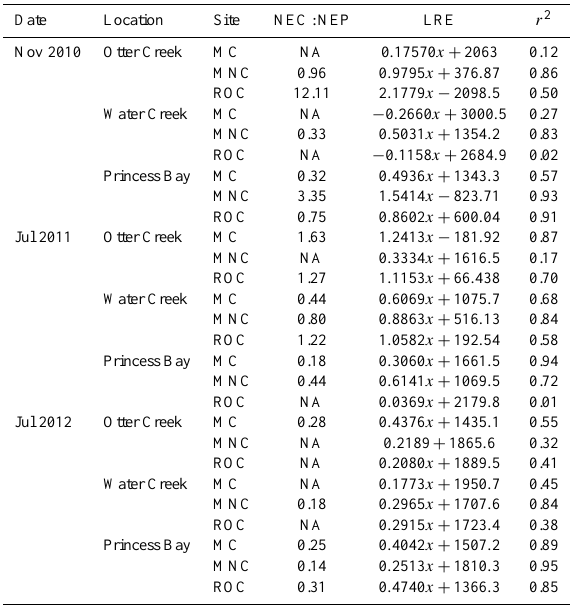
Table 6. Carbonate mineralogical composition of surface sedi- ments.